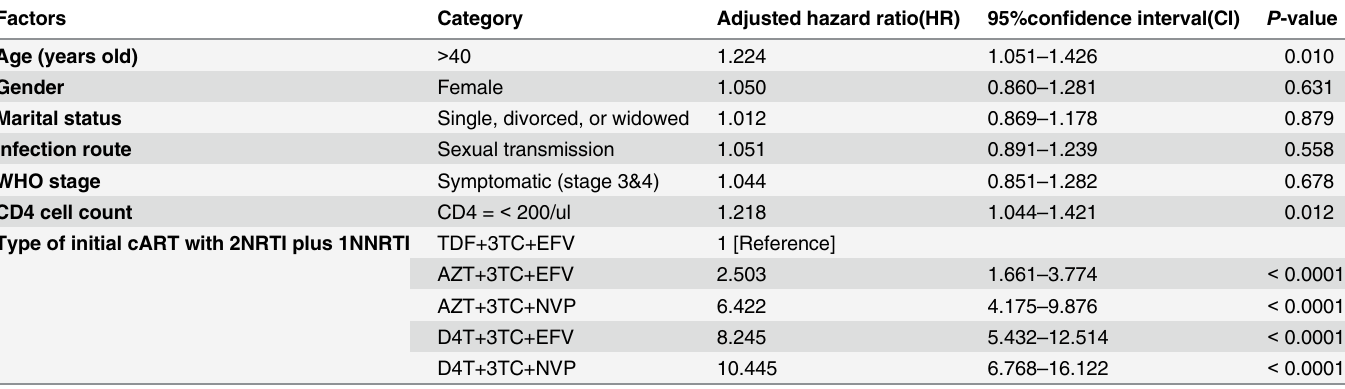
Table 2. Multiple regression analysis with Cox proportional hazards model for all the factors of regimen modification from the initiation of treat- ment to December 1st 2014.